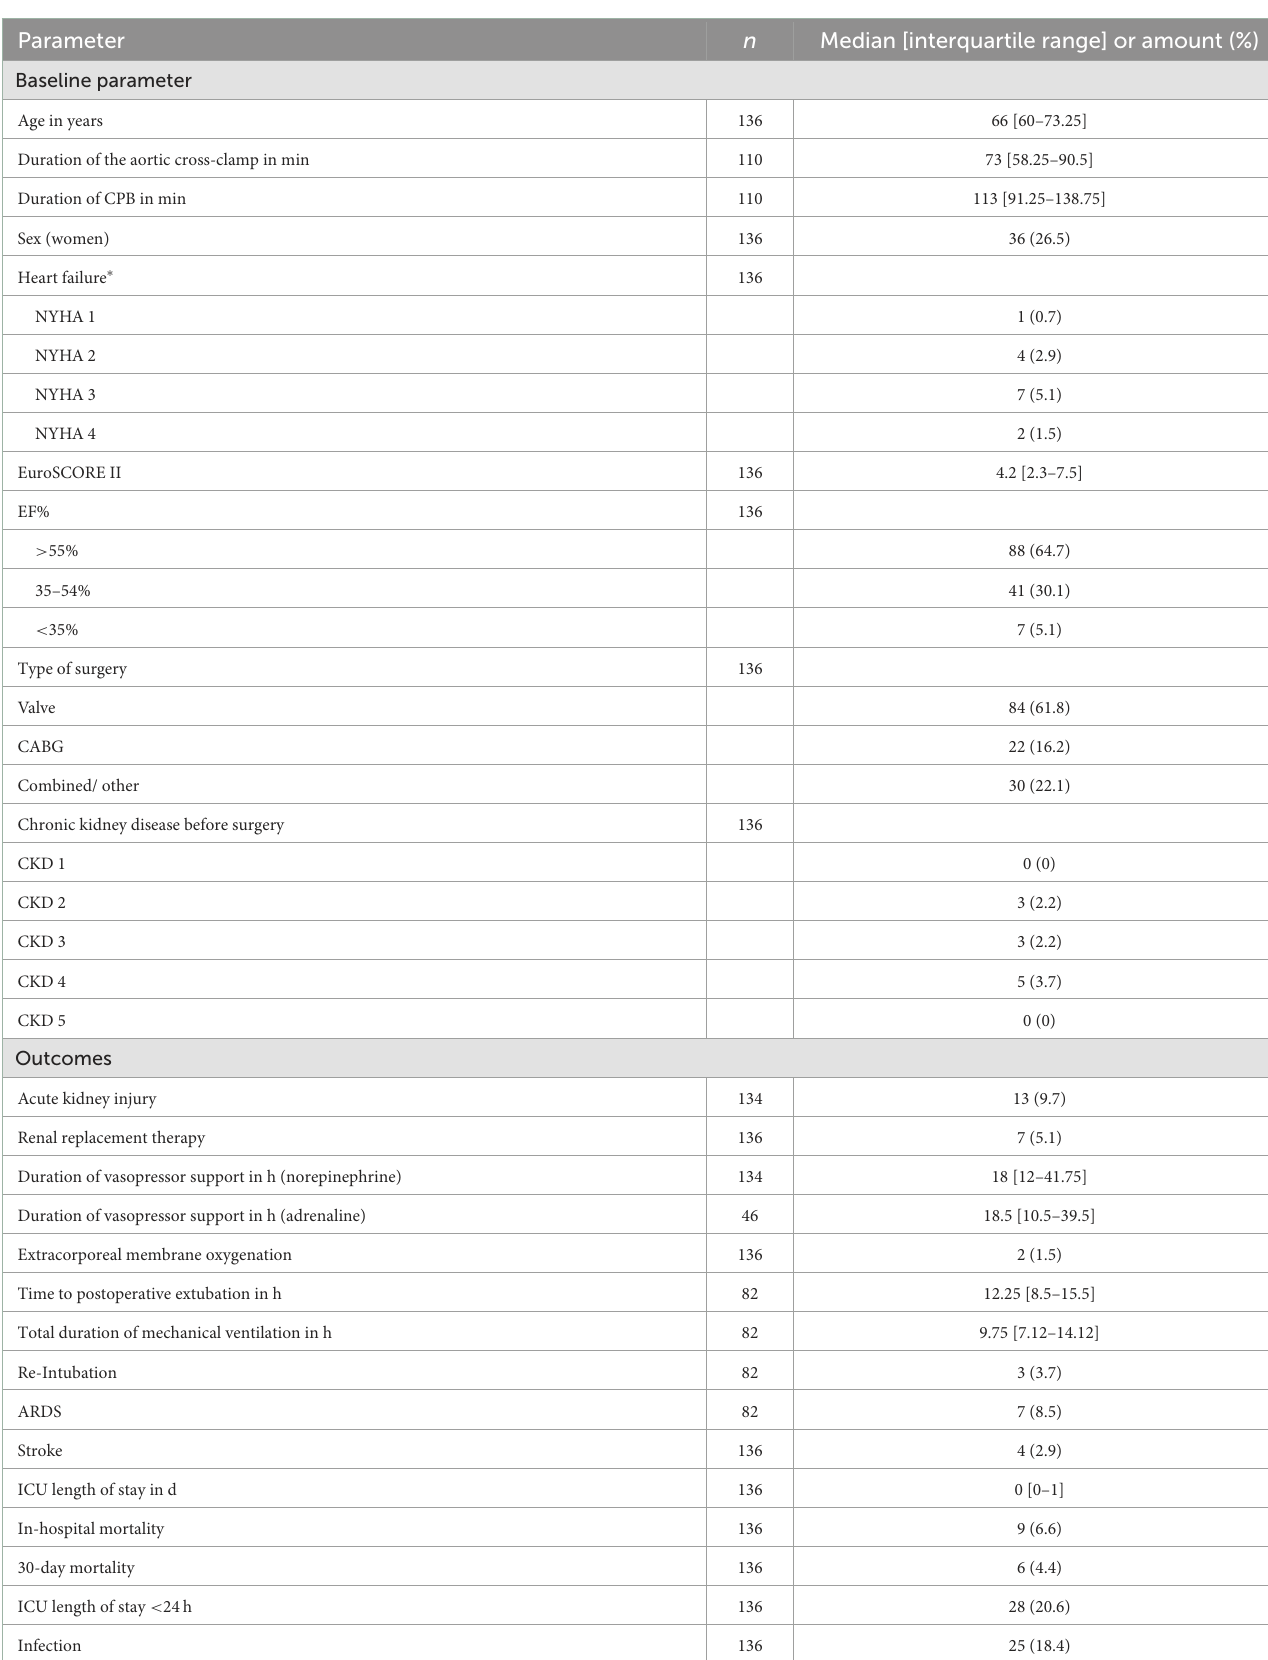
TABLE 1 Baseline characteristics of